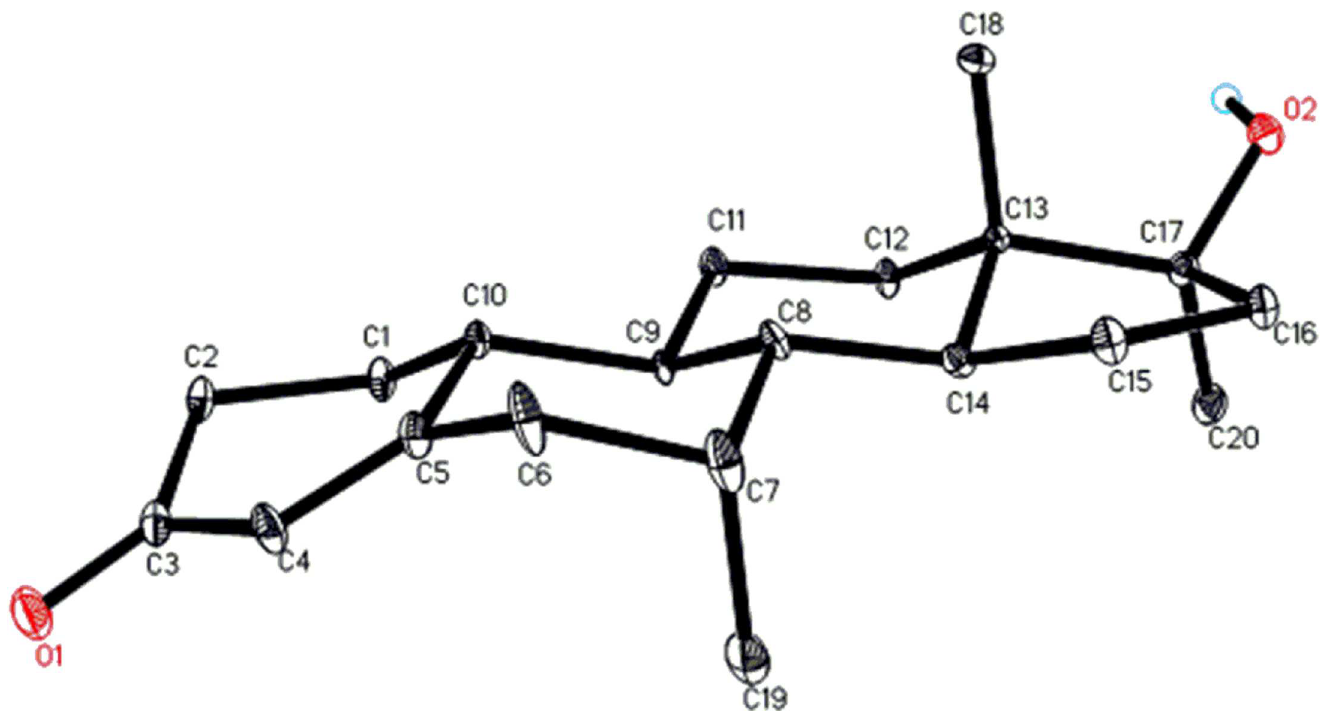
Fig 3. ORTEP drawing of X-ray structure of compound